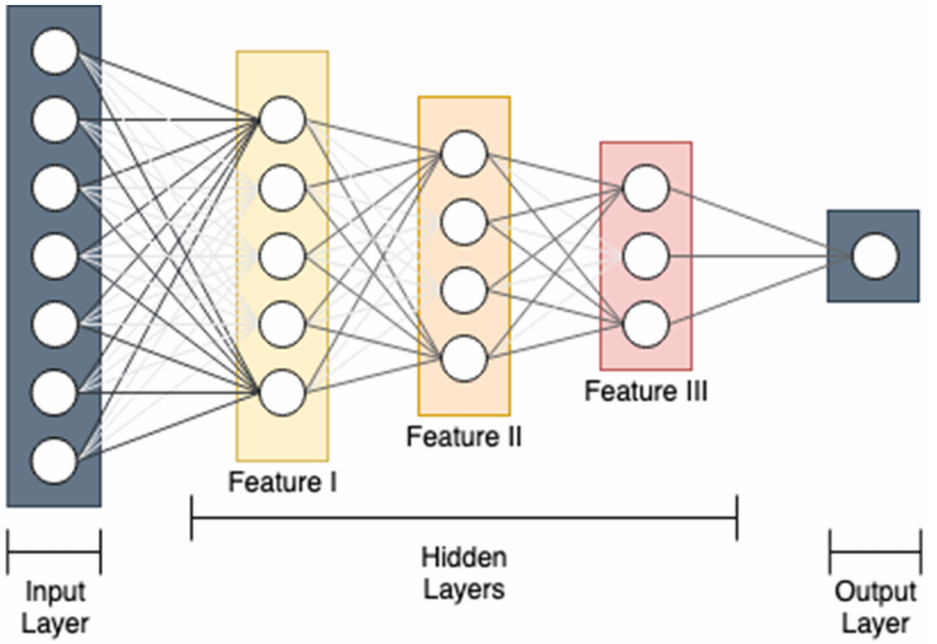
Figure 7. SAE architecture of stacked